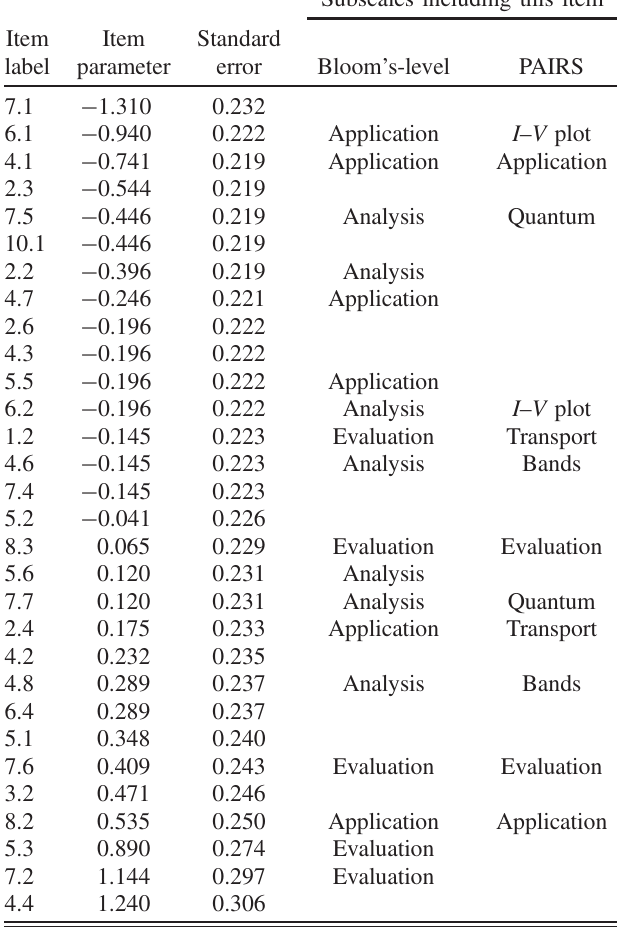
TABLE V. CML Rasch item parametrization for PSCI-AL- PHA. Item subsets can be extracted for quick diagnostic. Each item subset is a Rasch invariant scale. Items are listed in the ascending order of their difficulty. Std. Error ¼ standard error of the estimation; I – V plot, application, evaluation, quantum, trans- port, band are the names of the six pairs of items in the subset